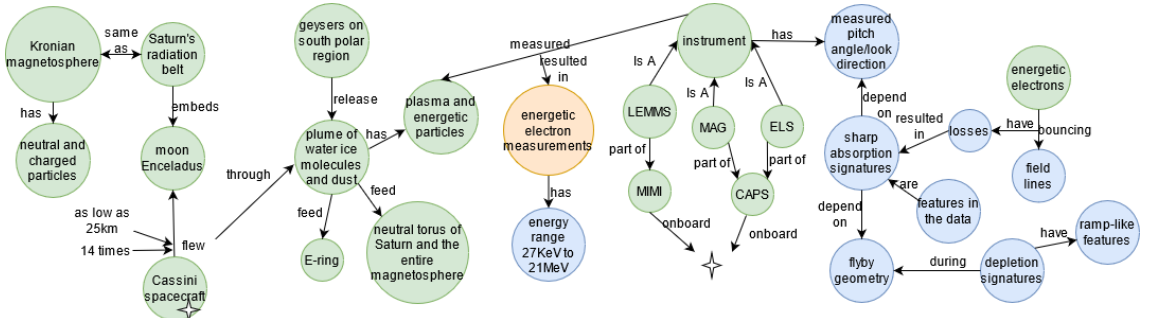
Figure A4. Structured KG representation of an Astronomy domain publication Abstract [68] as process, method, material, and data typed